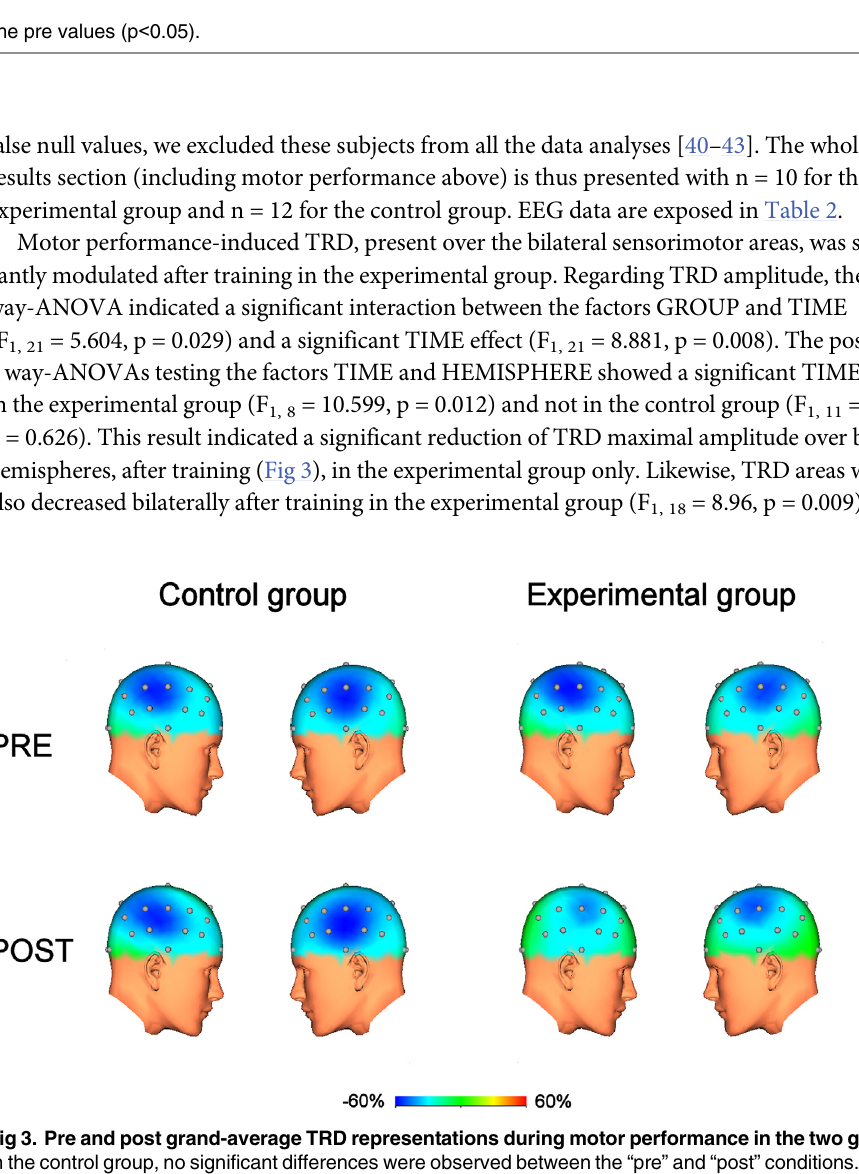
results section (including motor performance above) is thus presented with n = 10 for the